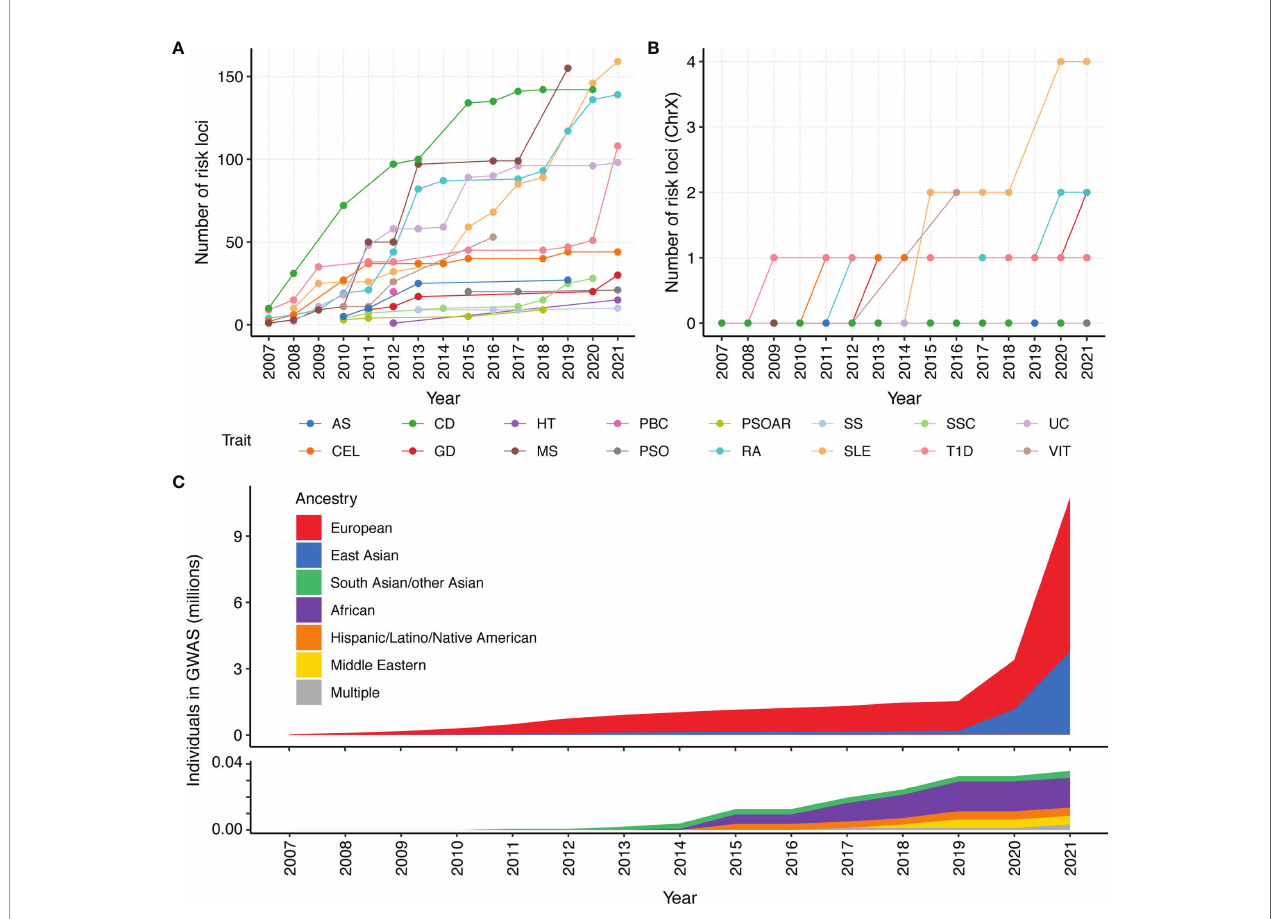
FIGURE 1 | Number of risk loci identi fi ed by GWAS for 16 autoimmune traits and ancestry composition per year since 2007. We count the cumulative number of reported loci in GWAS catalog. Each locus is de fi ned as a 1 million basepair window surrounding a genome-wide association signal (p < 5×10 -8 ). All signi fi cant variants within a 1 million basepair window are attributed to a single locus. The cumulative number of unique loci that were identi fi ed in a year were calculated for the (A) whole genome and (B) chromosome X. Given that the X chromosome represents approximately 5% of the genome, the paucity of X GWAS loci for most autoimmune disorders makes it clear that the X chromosome is understudied. (C) Cumulative assessment of GWAS participants by ancestry over time, according to GWAS catalog. A majority of current GWAS studies are from European ancestry. As people of European ancestry only account for 16% of the population, the non-European population remain